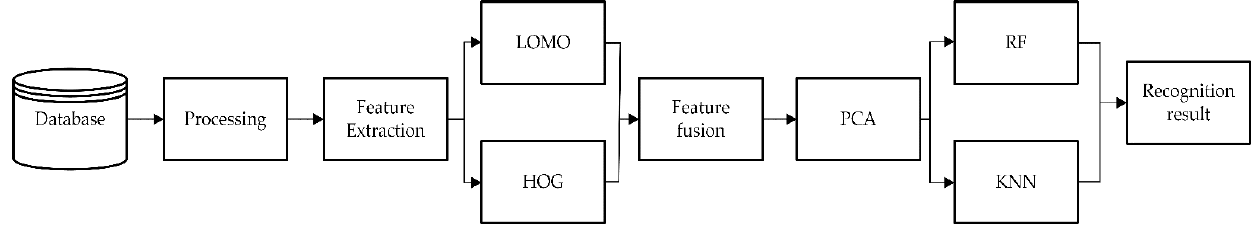
Figure 4. Offline handwritten signature recognition process.